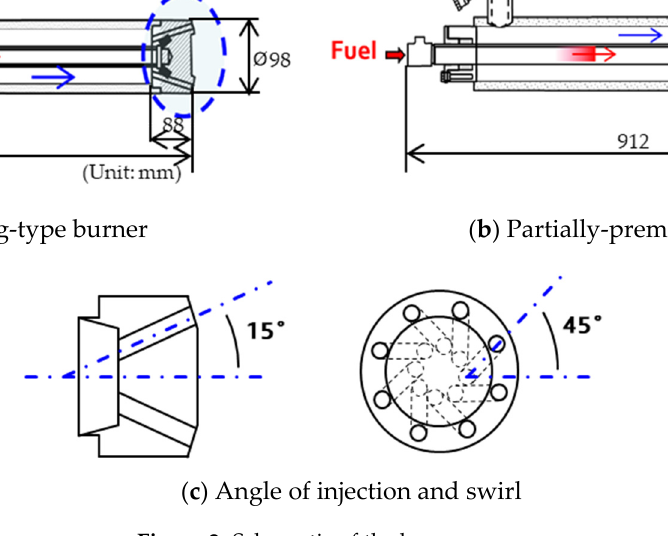
Figure 2. Schematic of the burners. Table 1. LNG (Liquefied Natural Gas) composition.